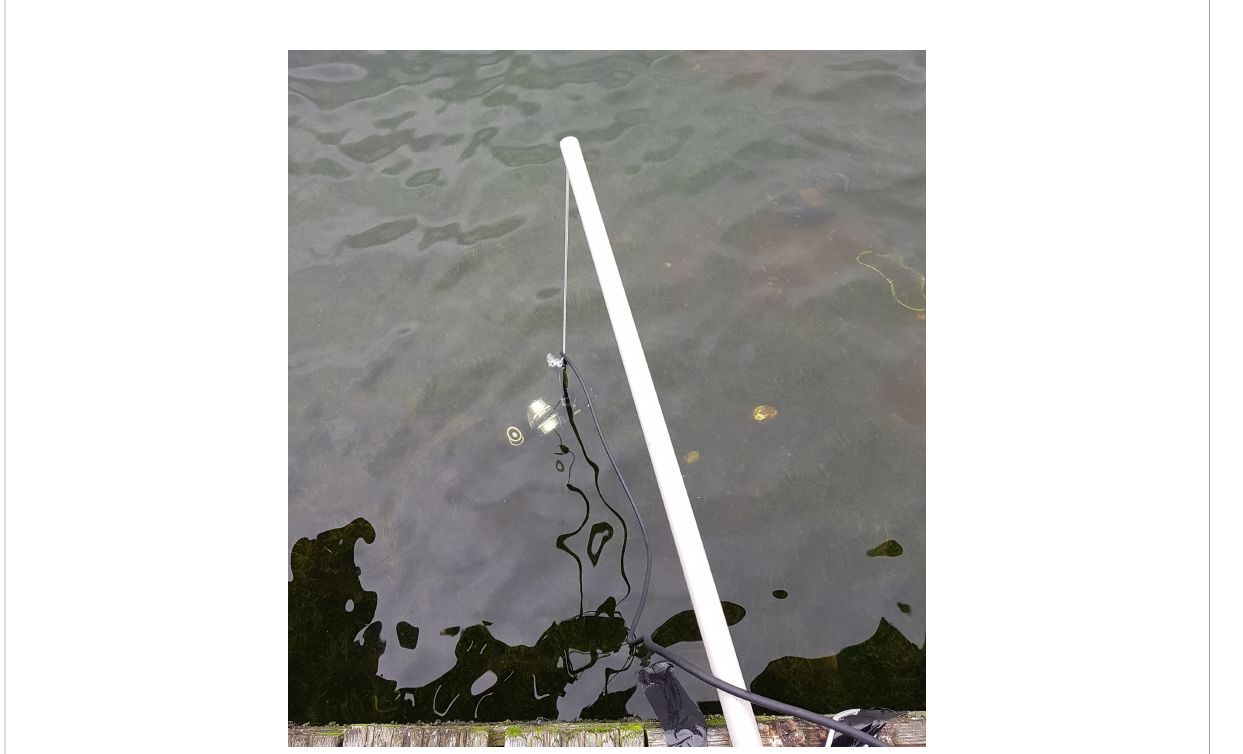
FIGURE 4 Measurements of the downwelling PAR at different depths, using two modules of the KduPRO and the LI-COR 192 as a reference sensor. In this experiment, we use the Lowering Frame to offer stability for proper orientation of